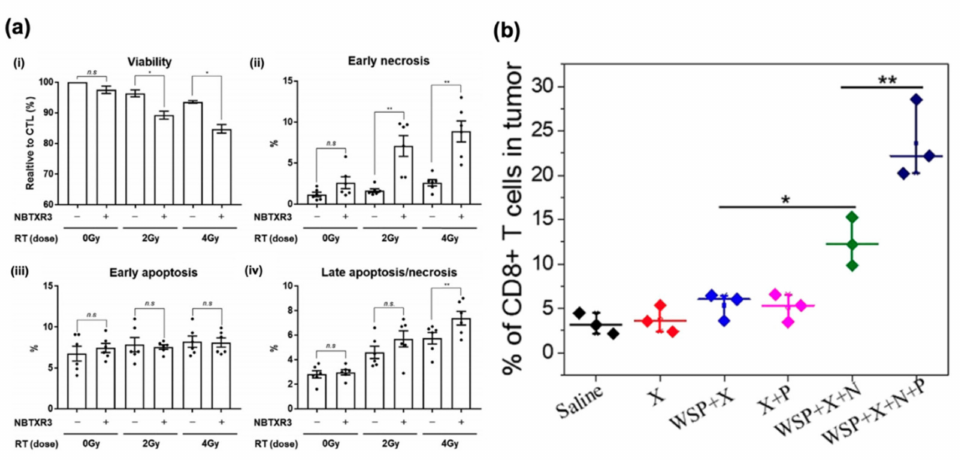
Figure 3. Immune response of radiosensitizers. ( a ) hafnium oxide particles increase necrotic cell death